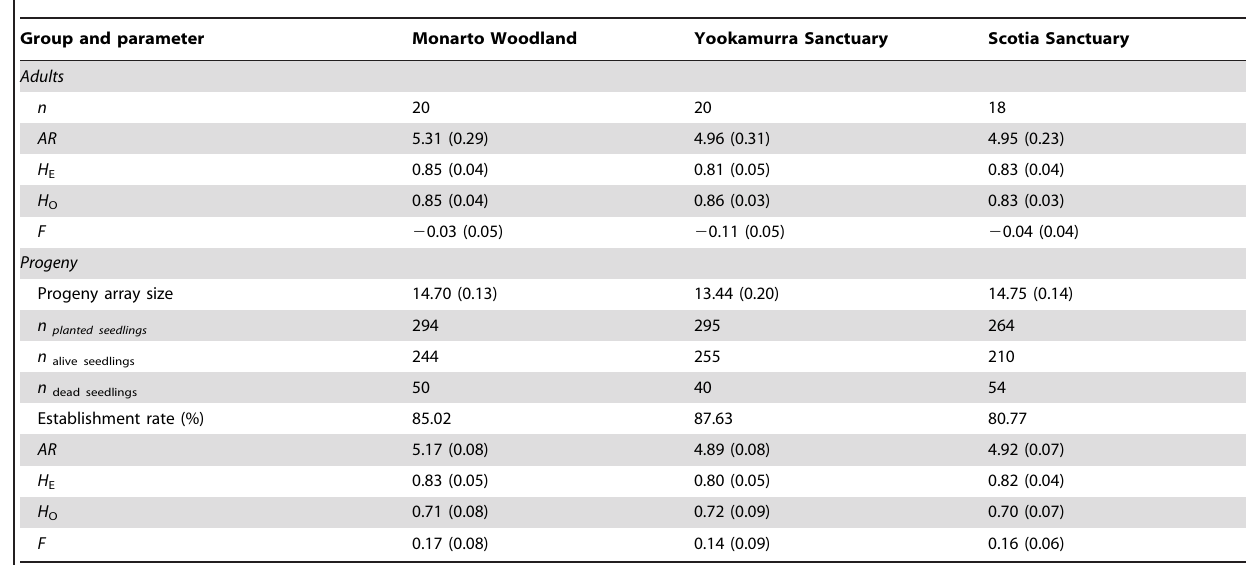
Table 1. Genetic variability of Eucalyptus gracilis populations at eight microsatellite markers, progeny array size and seedling establishment